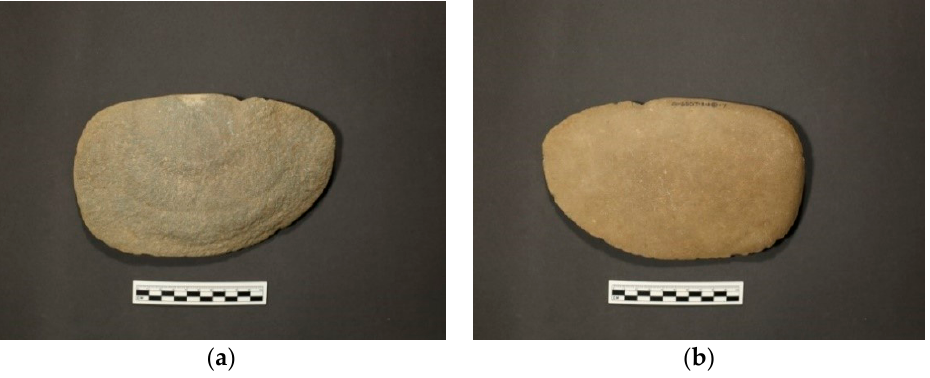
Figure 5. RHBF flakes in Guanzhou site: ( a ) ventral side, ( b ) dorsal side.